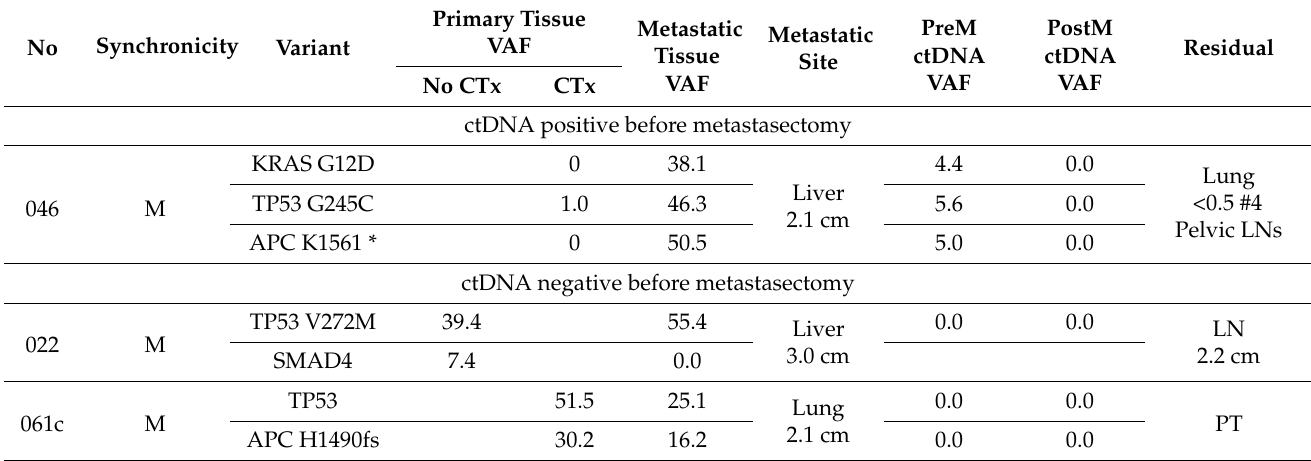
Table 3. Metastasectomy without Chemotherapy and Residual Disease ( N event =